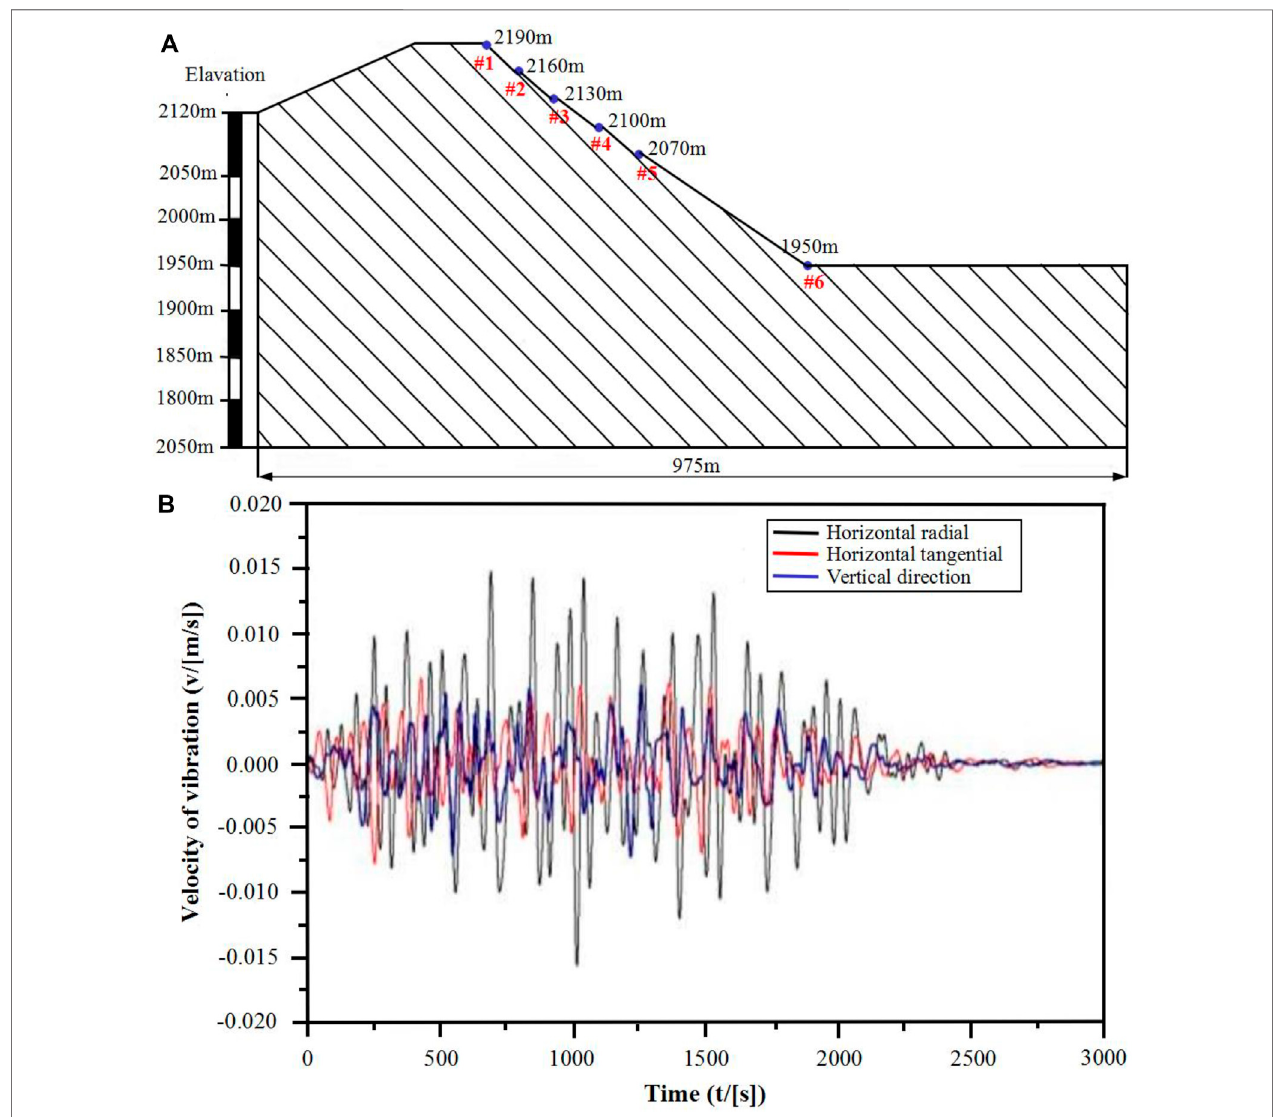
FIGURE 10 | Blasting monitoring of high and steep slopes. (A) Layout of high slope monitoring points; (B) Time-history curve of the vibration velocity of the measuring point at the 2070 platform on the east side of the Jianshan slope.